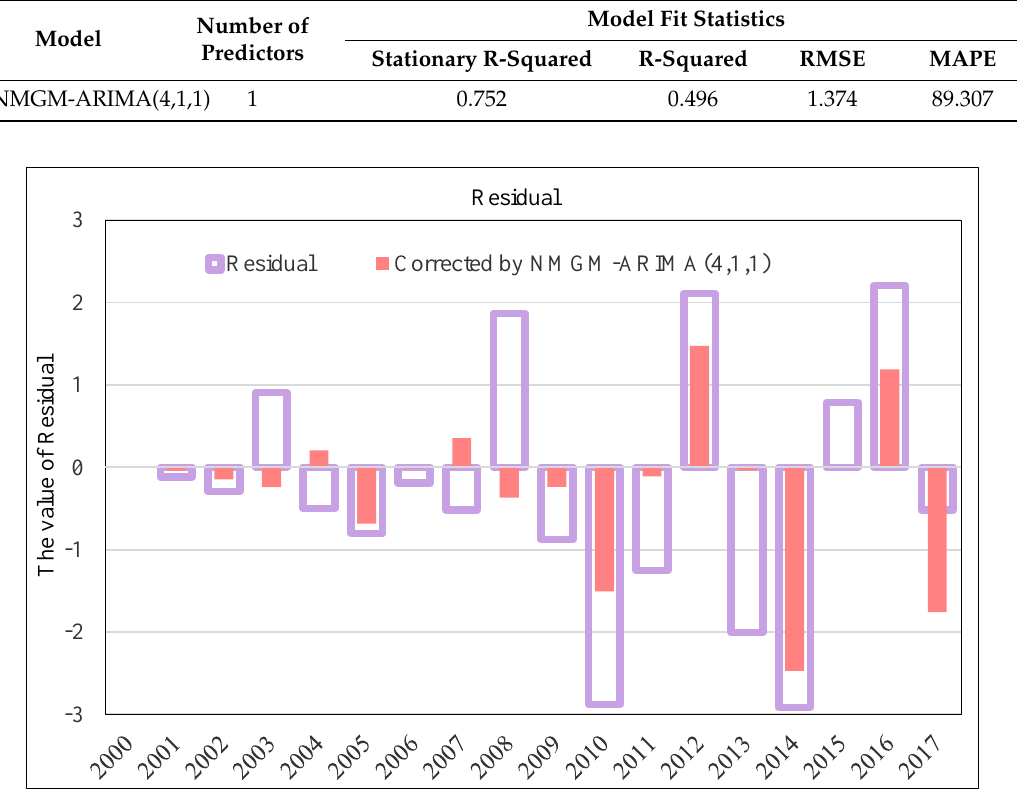
Table 13. Fitting results of five models (Unit:mtoe).